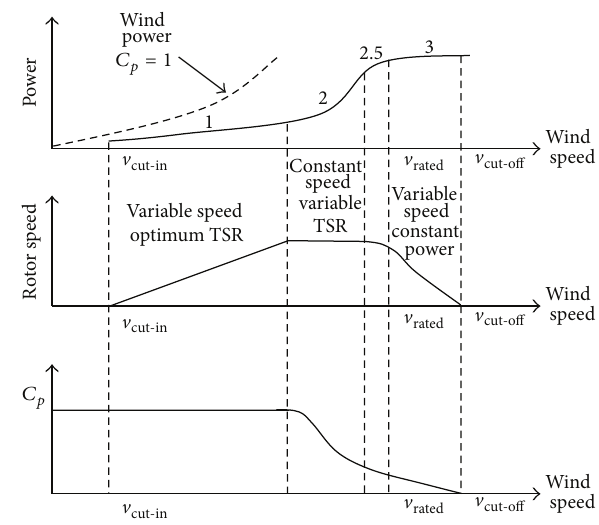
Figure 5: Wind turbine control region.